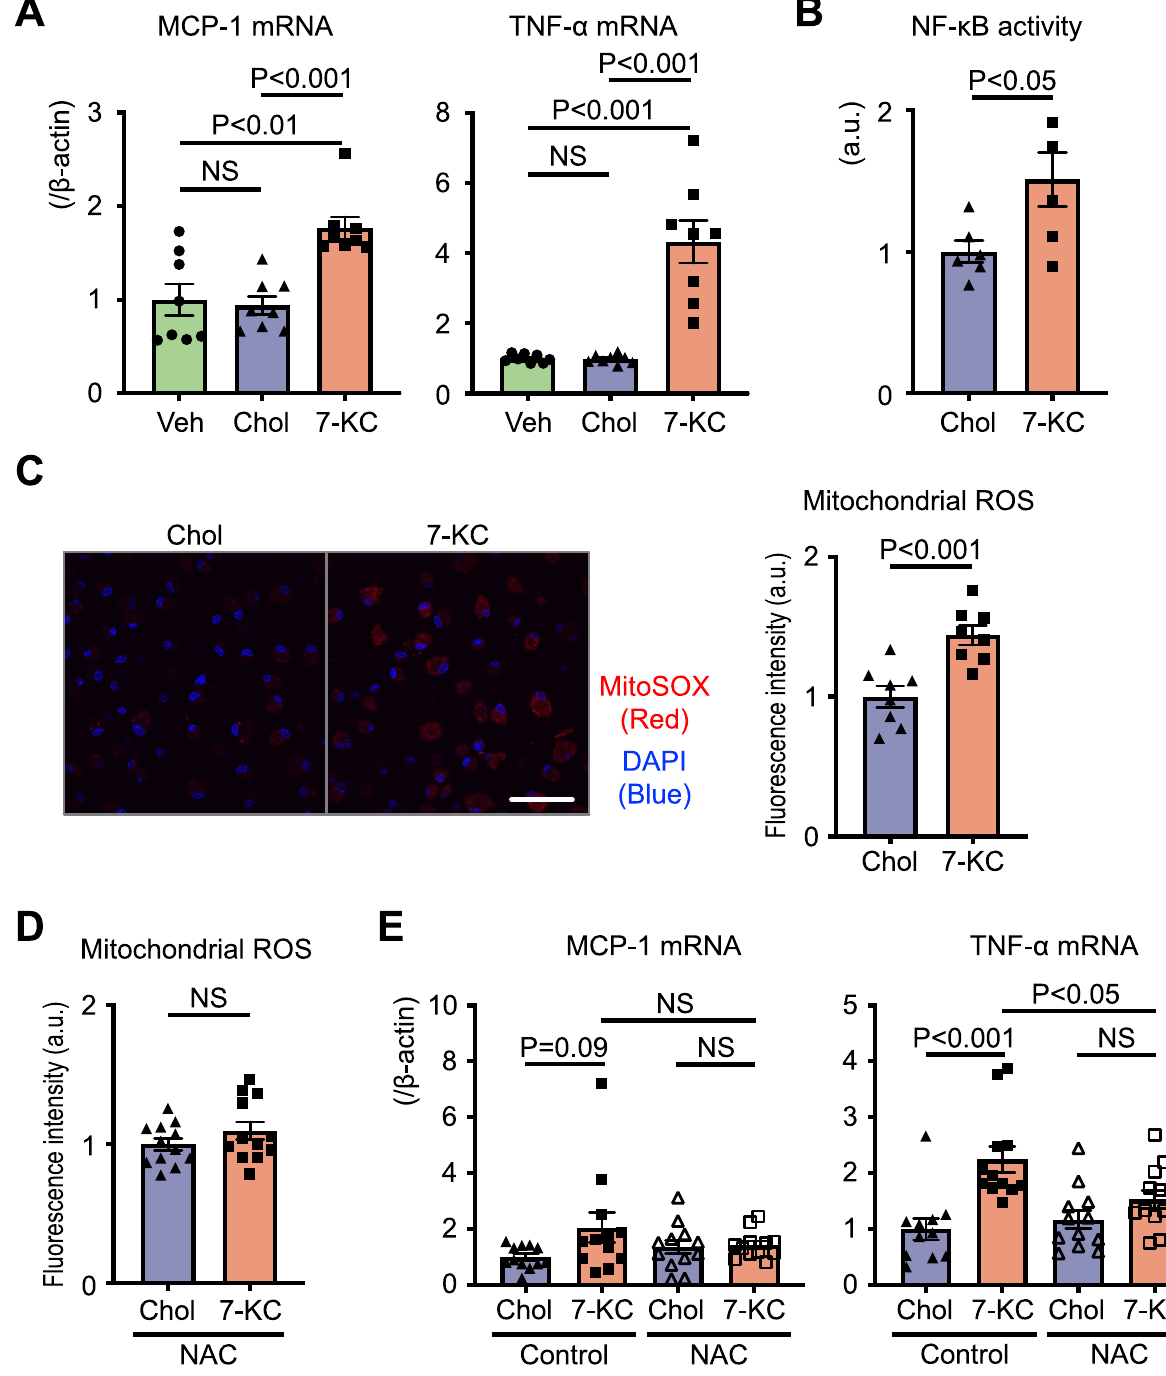
Figure 4. 7-KC induced inflammation and ROS production. ( A – C ) Peritoneal macrophages were treated with vehicle, 10 µM cholesterol or 7-KC for 24 h. ( A ) Expression of cytokines quantified by RT–PCR. N = 8. The data were analyzed by one-way ANOVA, followed by Tukey’s post-hoc multiple comparison test. ( B ) p65 in the nuclear fraction quantified by ELISA to represent NF-κB activity. N = 6. The data were analyzed by unpaired t test. ( C ) Mitochondrial ROS measured using MitoSOX. N = 8. Scale bar, 50 µm. The data were analyzed by unpaired t test. ( D ) and ( E ) Peritoneal macrophages were pretreated with 5 mM NAC for 1 h before 10 µM cholesterol or 7-KC treatment for 24 h. ( D ) Mitochondrial ROS measured using MitoSOX. N = 12. The data were analyzed by unpaired t test. ( E ) Expression of cytokines quantified by RT–PCR. N = 11–12. The data were analyzed by one-way ANOVA, followed by Tukey’s post-hoc multiple comparison test. Veh, vehicle; Chol, cholesterol; 7-KC, 7-ketocholesterol; ROS, reactive oxygen species; NAC,